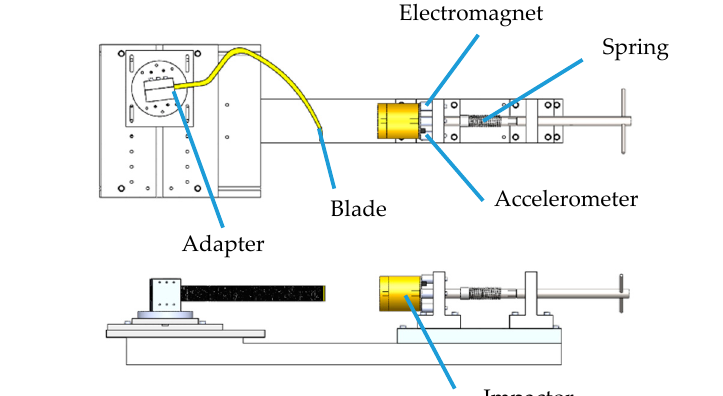
Figure 1. The developed impact testing apparatus. The impact speed can be controlled by adjusting the compressed length of a coil spring, and the position of the blade can be